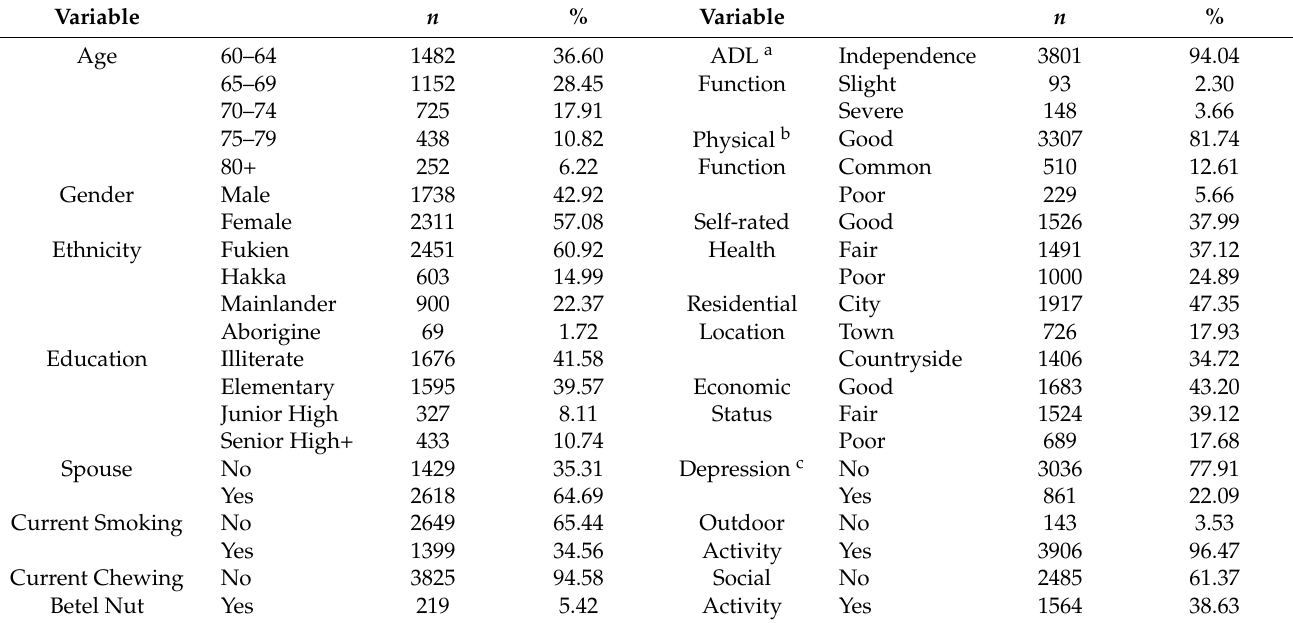
Table 1. Characteristics and status of respondents in